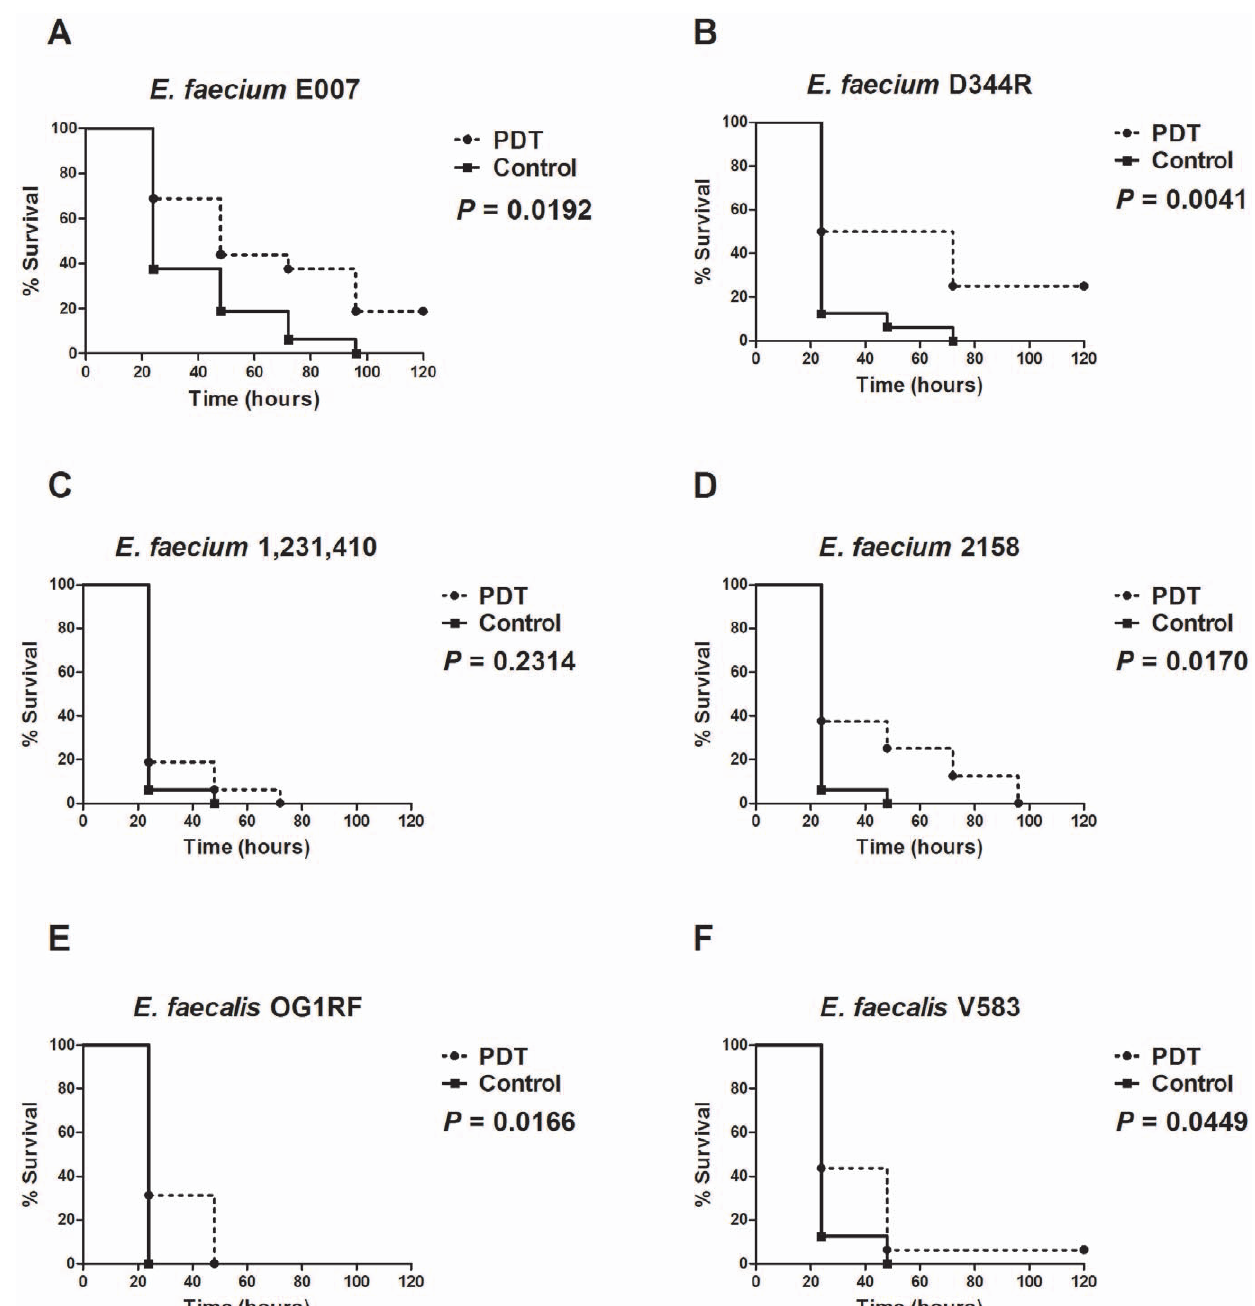
Figure 5. Killing of G.mellonella by E.faecium and E.faecalis exposed to antimicrobial PDT. In the aPDT group, the larvae received the PS injection 90 min after the bacterial infection. In order to allow a good dispersion of the PS into the insect body, we waited at least 30 additional min after the PS injection prior to the light irradiation. Control group received PS without light exposure. A) E. faecium E007 tetracycline resistant (3.0 6 10 7 CFU/larva), B) E. faecium D344R ampicillin resistant (1.08 6 10 7 CFU/larva), C) E. faecium 1,231,410 vancomycin resistant (4.8 6 10 7 CFU/larva), D) E. faecium 2158 used in the mouse peritonitis model (1.25 6 10 7 CFU/larva), E) E. faecalis OG1RF rifampin and fusidic acid resistant (1.7 6 10 6 CFU/ larva), F) E. faecalis V583 vancomycin resistant (1.3 6 10 6 CFU/larva). A representative example was used for each